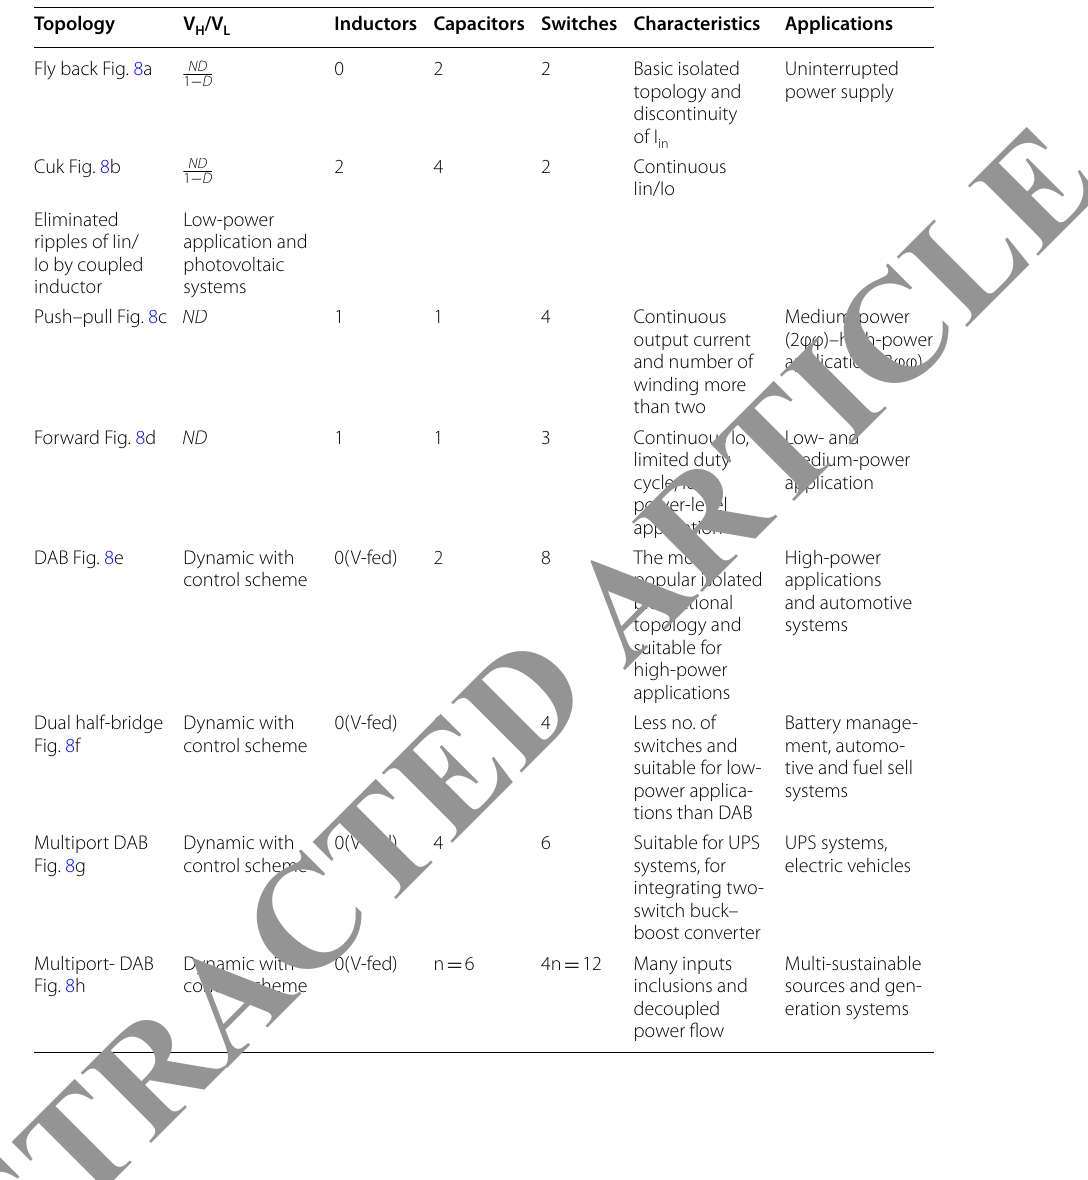
Table 2 Assessment of isolated bidirectional DC-DC converters Topology V H /V L Inductors Capacitors Switches Characteristics